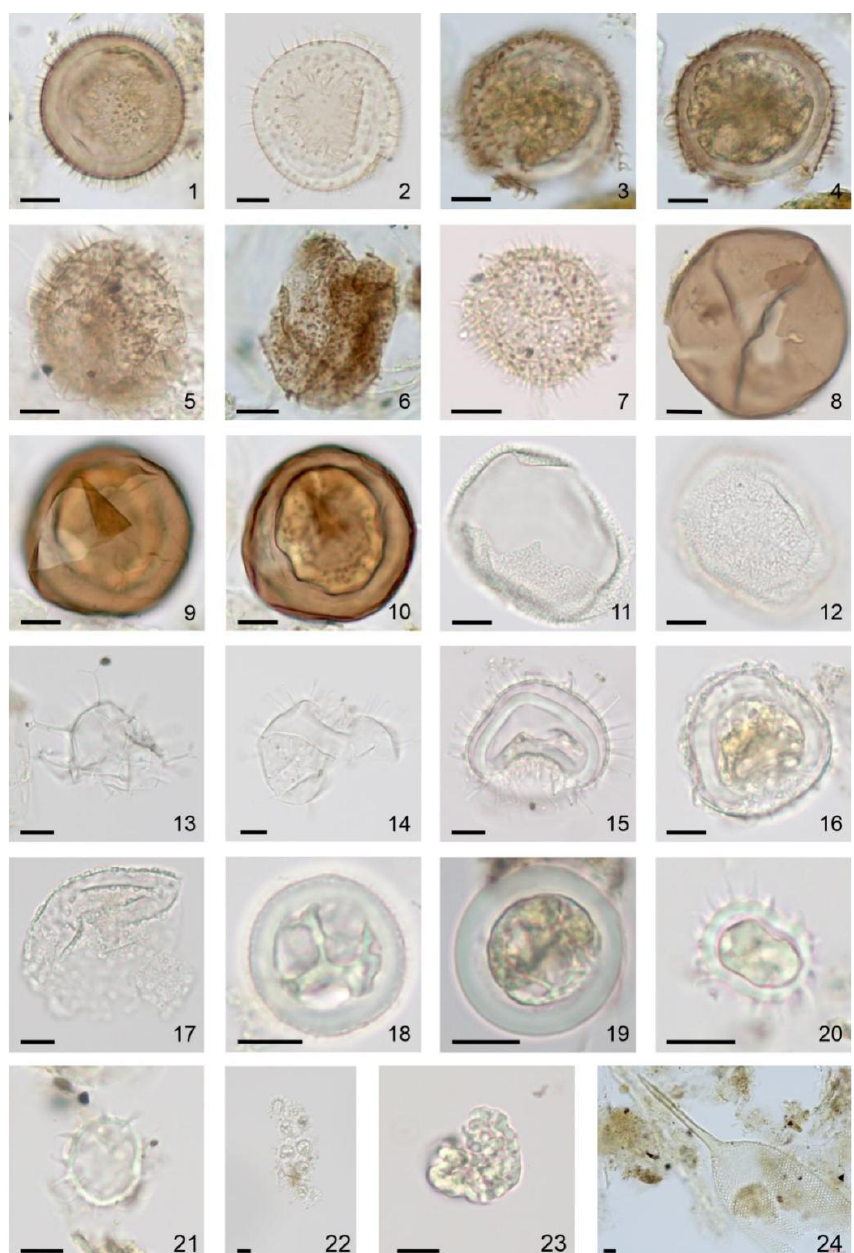
Figure 8. Photomicrographs (bright-field images) of dinoflagellate cysts and NPP recovered from 2017 to 2018 sediment trap moorings in the Barents Sea, taken with an Axiocam 305 color microscope camera mounted on a Zeiss Axio Imager.A2 light microscope with N-Achroplan 10x/0.25 (image 22, 24), EC “ Plan-Neofluar ” 40x/0.75 (images 1 – 17, 23), N-Achroplan 63x/0.85 (images 18 – 21) objectives. Black scale bar is 10 μm. ( 1 ). Islandinium minutum subsp. minutum , optical section, August